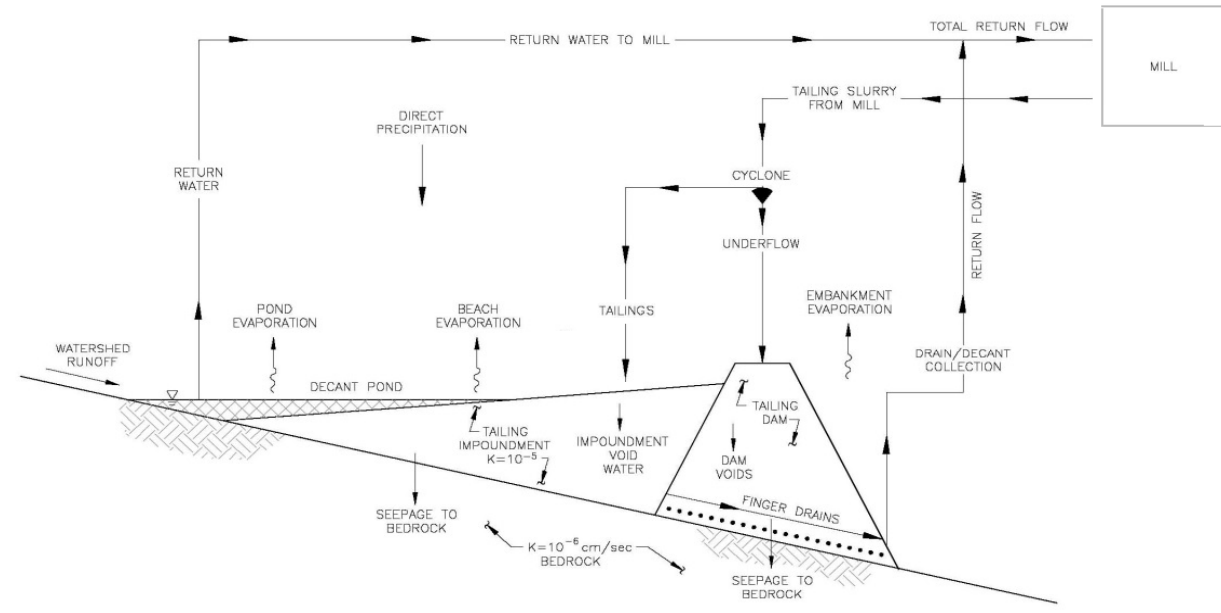
Figure 2. Typical process water management and seepage control in a